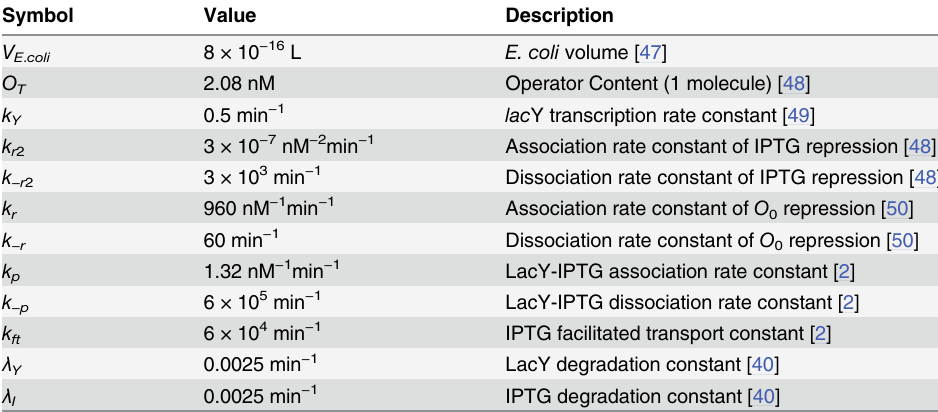
Table 1. Parameters of the lac operon reaction